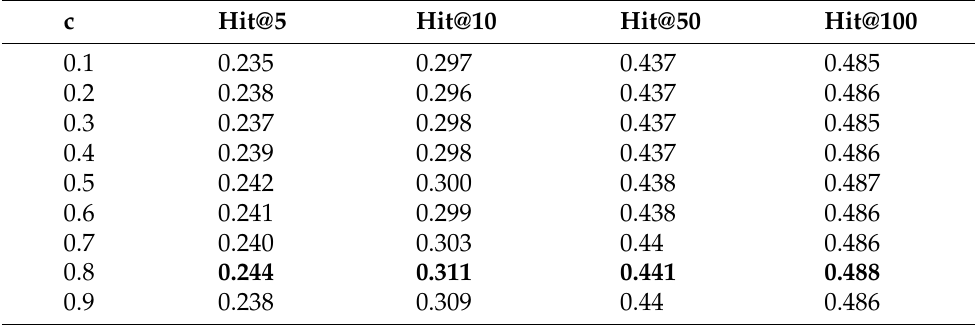
Table 6. Prediction accuracies of the CWS model with different values of c; the best results are shown in